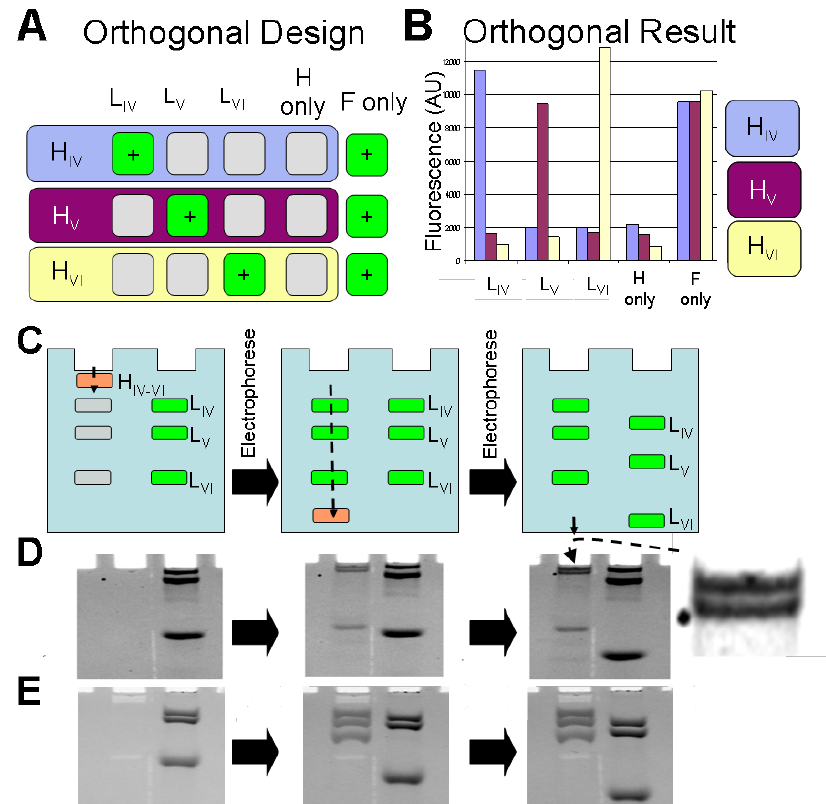
Figure 3. Multiple line generator reactions. ( A ) Schematic of the intended interaction network among three different instances of the fluorogenic reaction; ( B ) Experimental results showing the fluorescence increase resulting from all possible combinations of the reagents of the three reactions. Only the intended combinations show fluorescence; ( C ) The order of operations is shown as a schematic illustration; ( D ) Fluorescence images of the experimental results showing the location of the fluorescein-labeled L well as the newly generated fluorogenic features in the left lane; ( E ) The same experimental protocol was applied with a different version of L generated line (produced by L /H ) is directly between those produced by L Vb V L /H VI VI